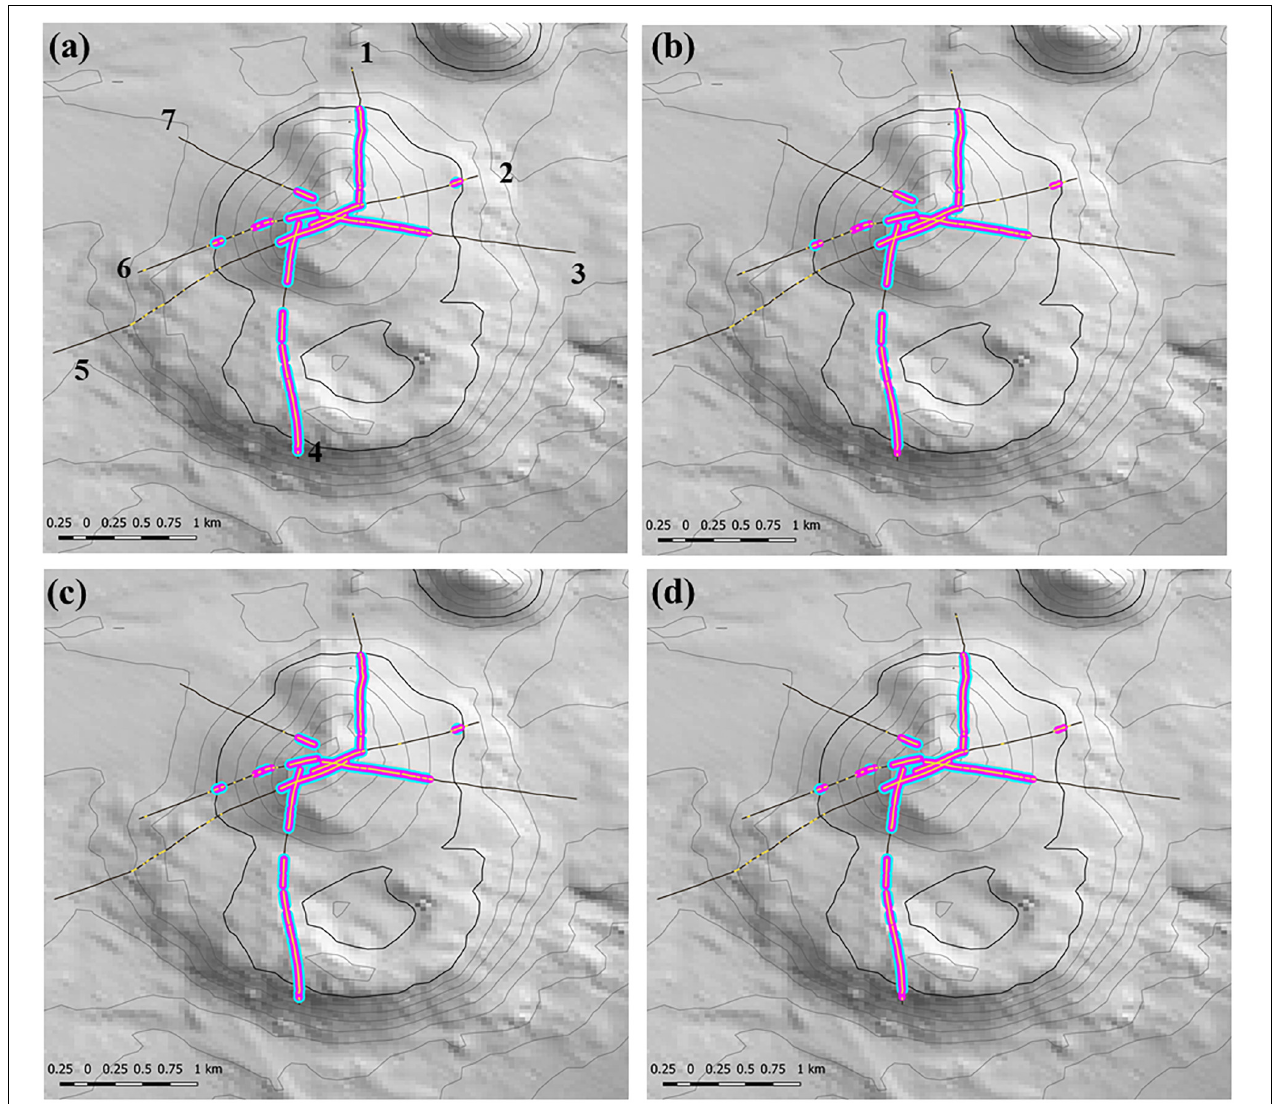
FIGURE 9 | Transect-scale effects of changing parameters used to map coral reef VME habitat: example from site 11 (Hill U). Maps show transects (heavy black lines), the raw distribution of the matrix-forming stony coral Solenosmillia variabilis (yellow); segments defined as having VME habitat status (pink), and coral reef VME habitat (blue). Panel (a) shows transect numbers. Scenarios: (a) base-case with 2.78 live head threshold; (b) base-case with 5.6 live head threshold; (c) 25% cover and 2.78 live head threshold; (d) 25% cover and 5.6 live head threshold. Depth contours: 50 m intervals with 1350 line